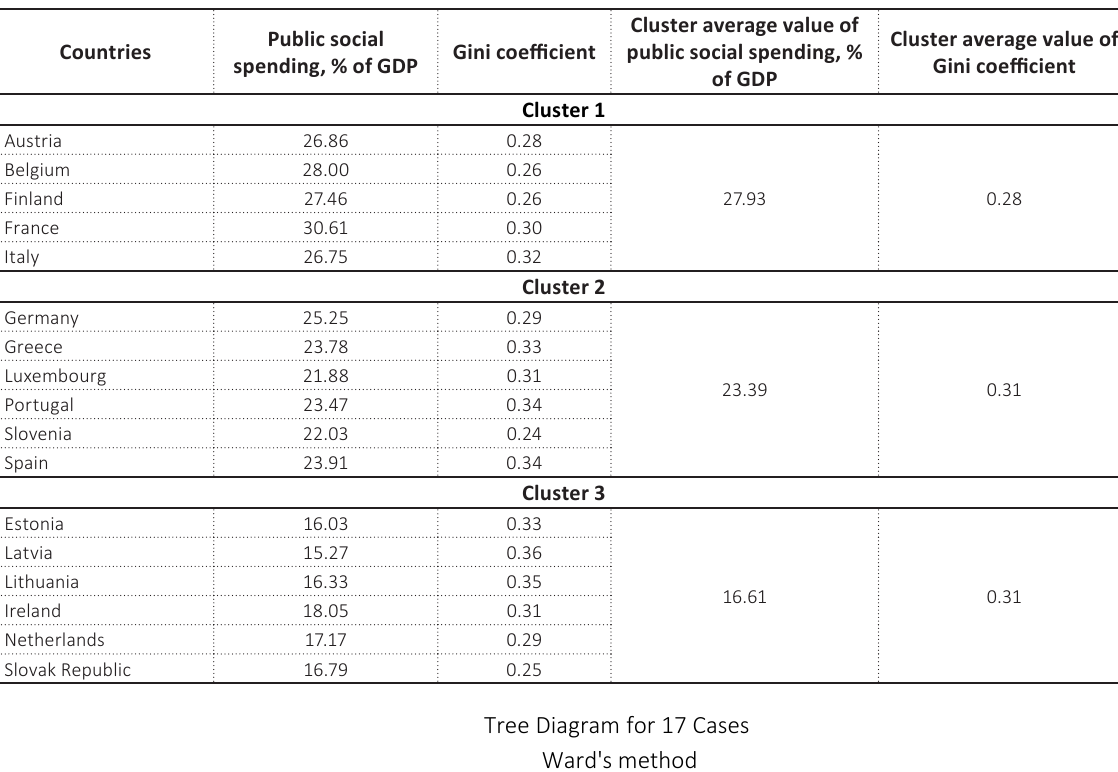
Tree Diagram for 17 Cases Ward ' s method